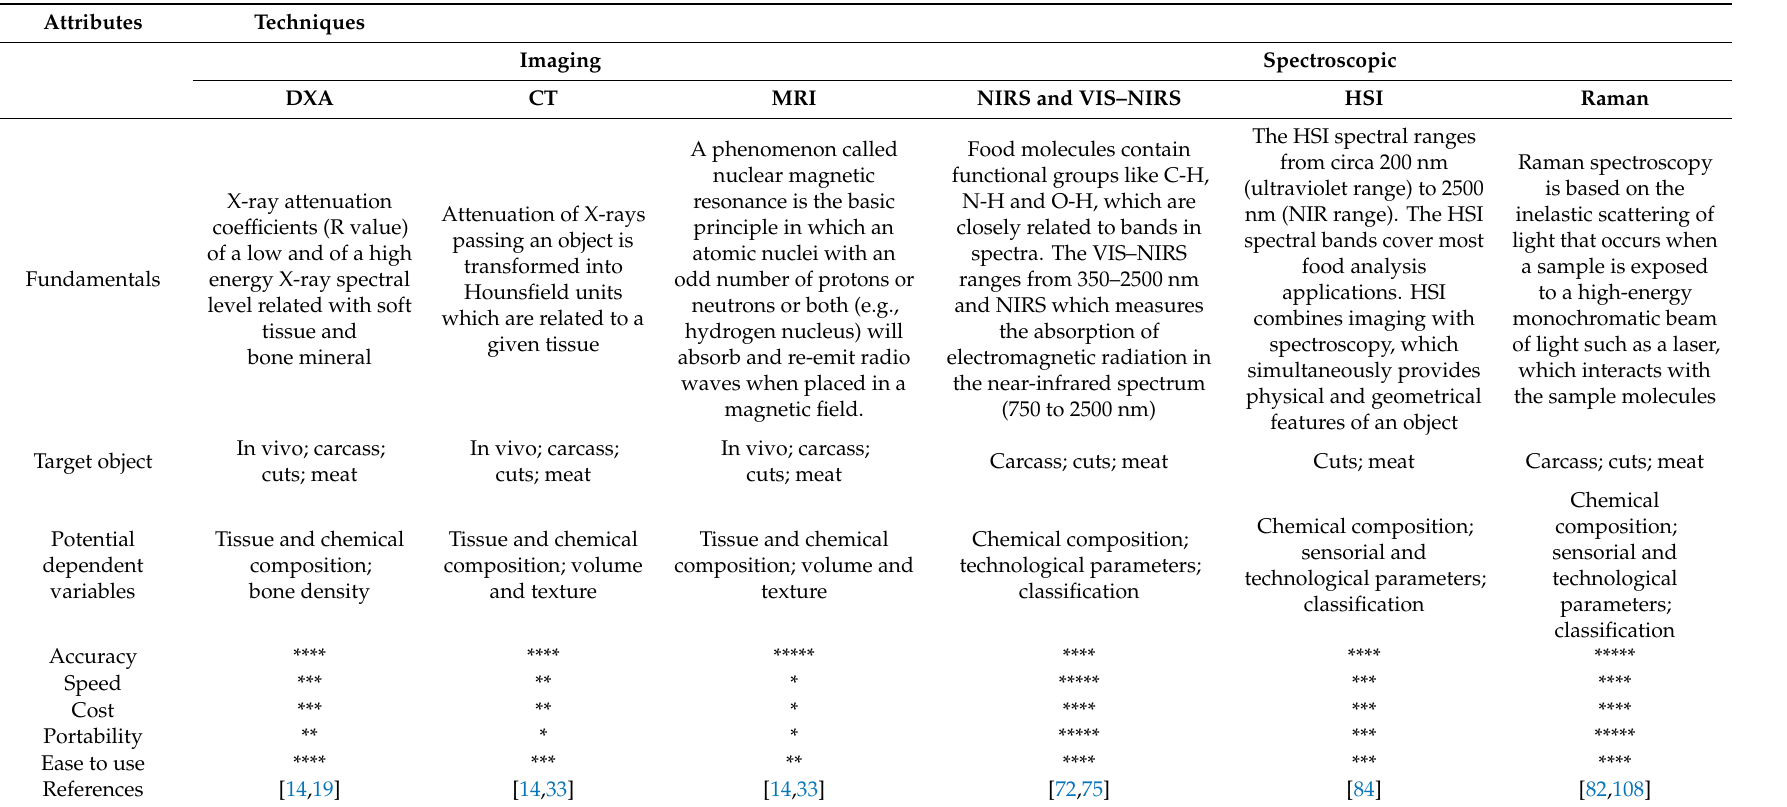
Table 8. Summary of several attributes of the imaging and spectroscopic